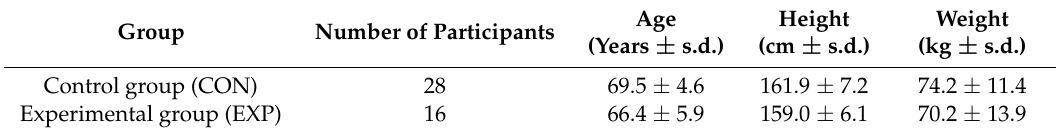
Table 1. Characteristics of examined group (mean ± standard deviations).